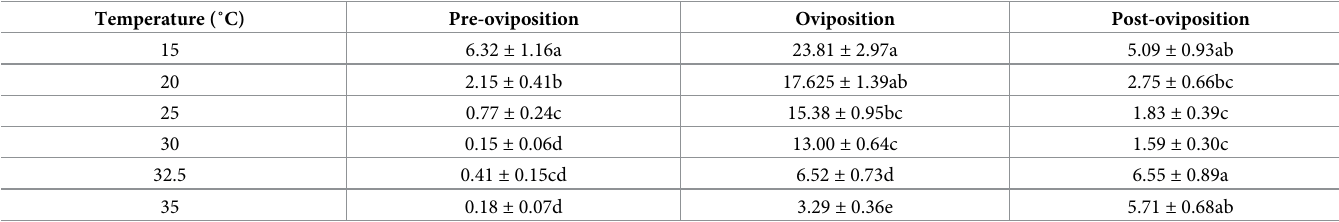
Table 3. Pre-oviposition, oviposition, and post-oviposition durations (mean ± SE in days) for Diachasmimorpha longicaudata at different temperatures. Temperature